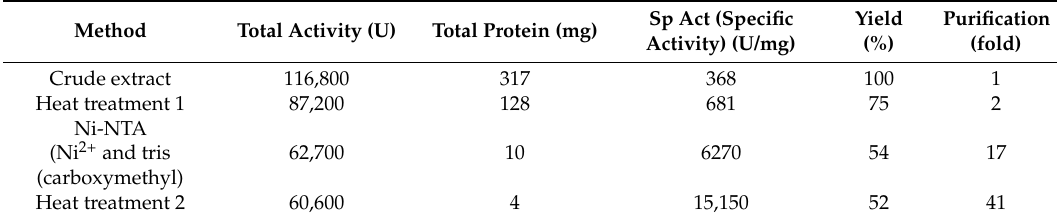
Table 1. Purification of recombinant enzyme from E. coli BL21 (DE3)